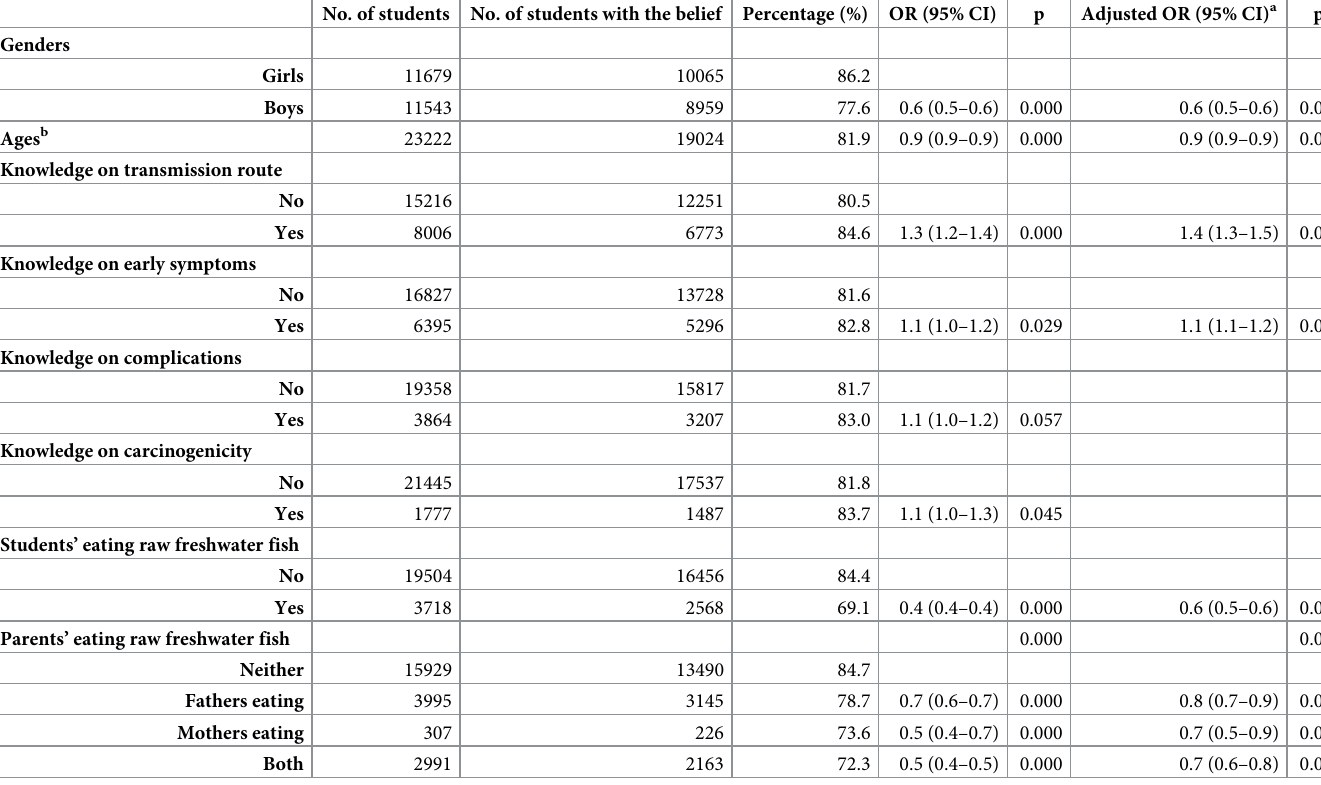
a Genders, ages, knowledge on transmission route, knowledge on early symptoms, students’ practice and parents’ practice were included in multivariate logistic regression. b Ages were a continuous variable in logistic regression